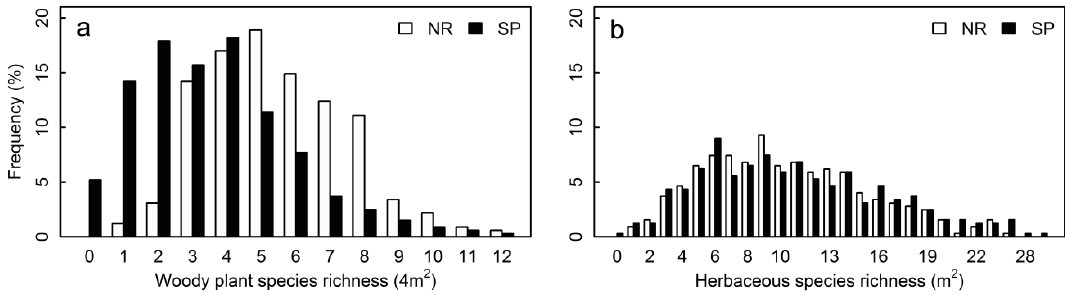
Figure 2. Frequency distribution of species density for woody plant species in four m 2 quadrats ( a ) and for total herbaceous species in one m 2 quadrats ( b ) within the naturally regenerated forests (NR) and reforested spruce forests (SP) originating from similar clear-cuts in the eastern Tibetan